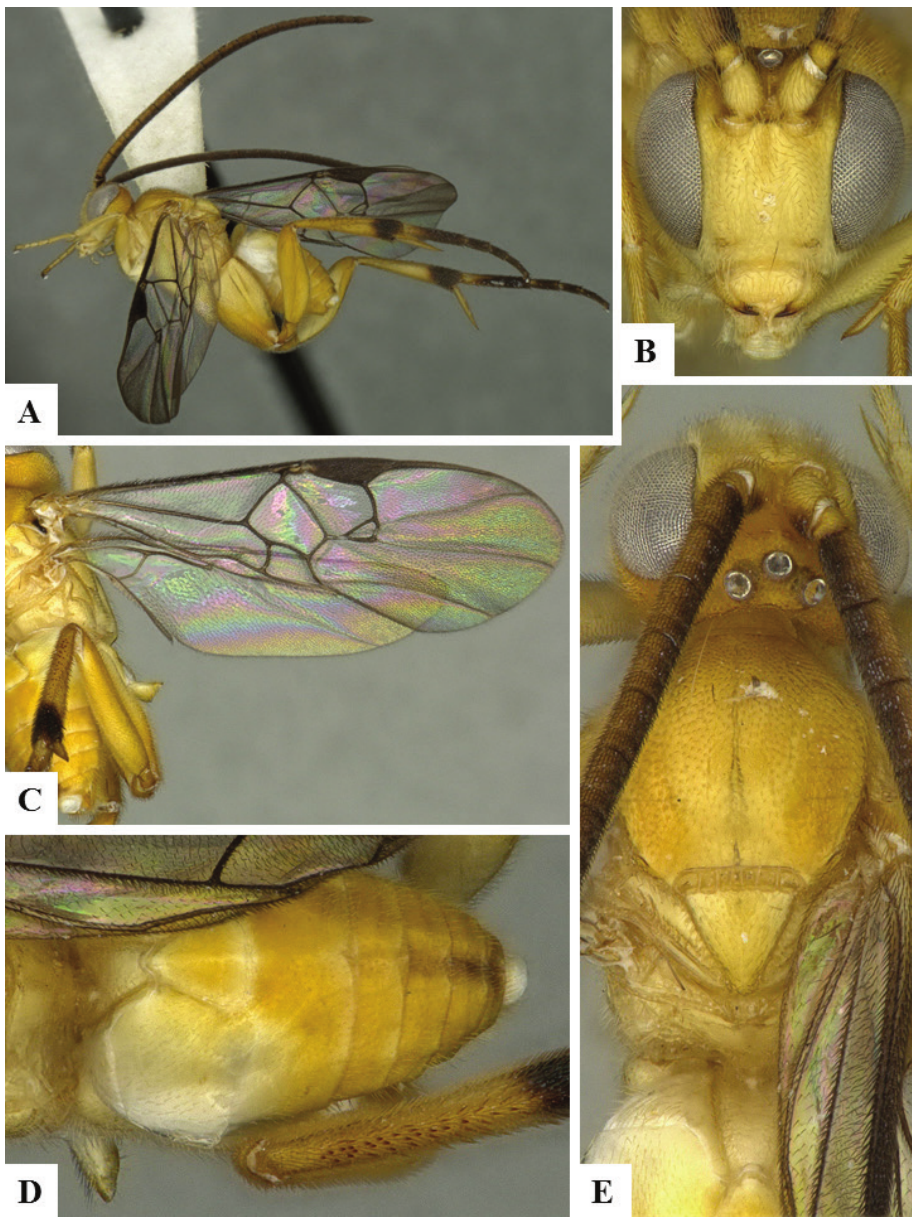
Figure 22. Jimwhitfieldius jamesi female holotype. A Habitus B Head frontal C Fore wing and hind wing D Metasoma dorsal E Head and mesosoma,